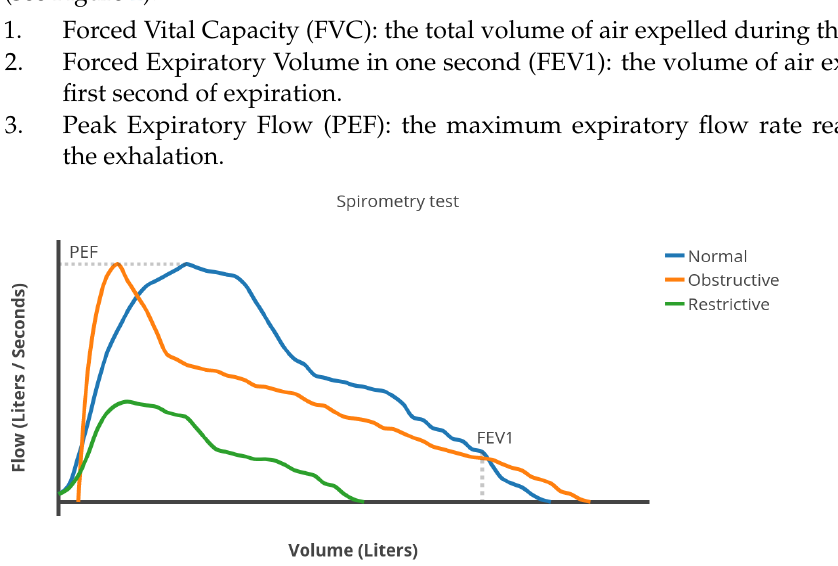
Figure 2. Example of different flows rates in a spirometry